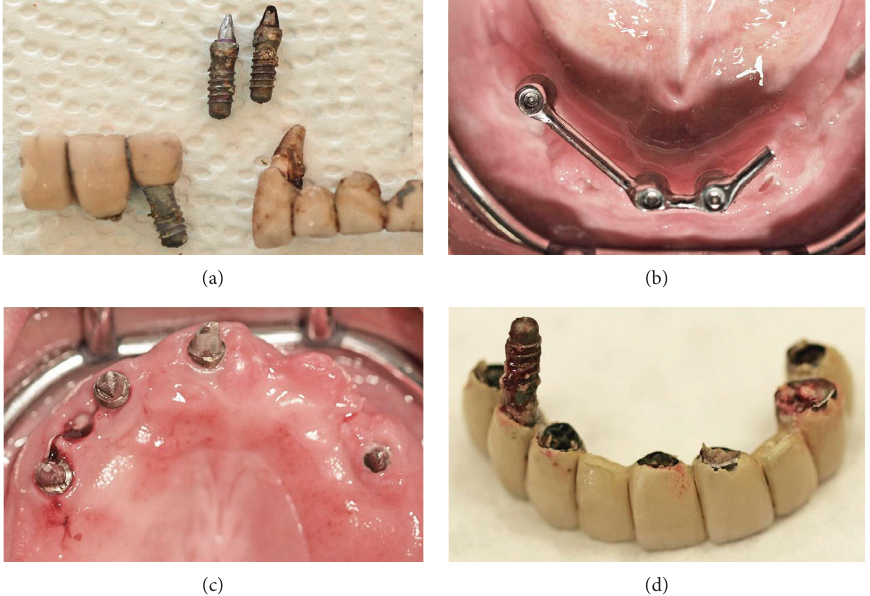
Figure 6: (a) Explanted mandibular implants and tooth #27. (b) Clinical view of the mandible 4 weeks postoperatively, before membrane removal. (c) The maxilla after FPD removal. (d) Explanted maxillary implant during FPD